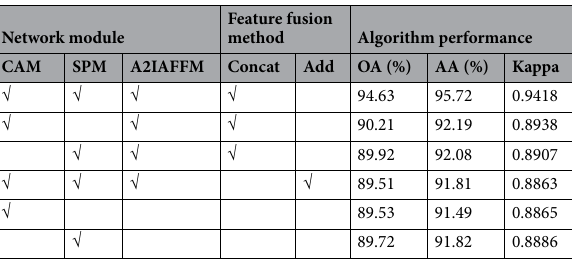
Table 7. Ablation analysis on Botswana dataset.